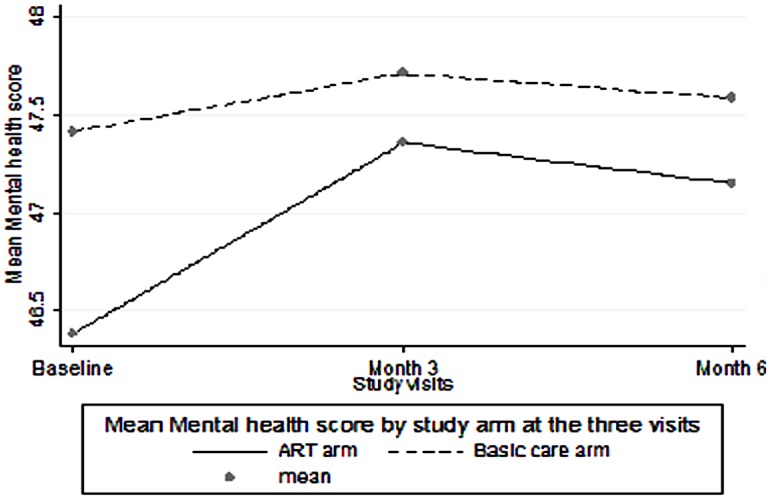
Mean Mental Health Scores over six months.Comparison of Mental Health Score means ART versus basic care among PLHIV over the follow up period.